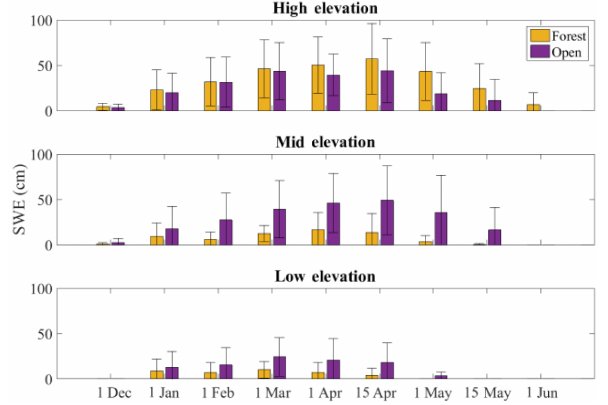
Figure 2. Average snow water equivalent (SWE) for the Open and Forest sites within the ForEST network, WY